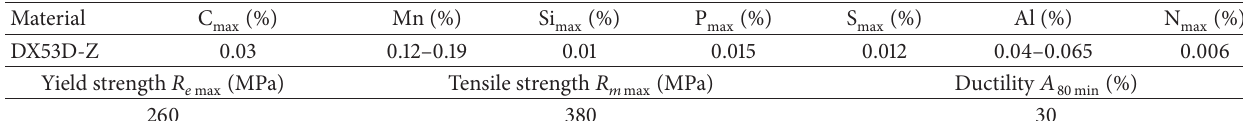
Table 1: Chemical and mechanical properties of substrate material.